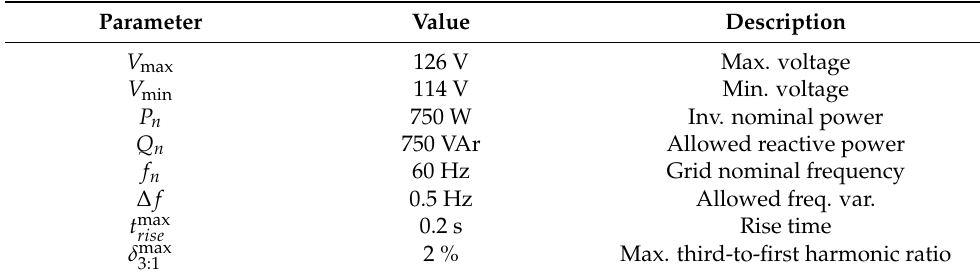
Table 1. Input parameters from Reference Method (RM) [21].